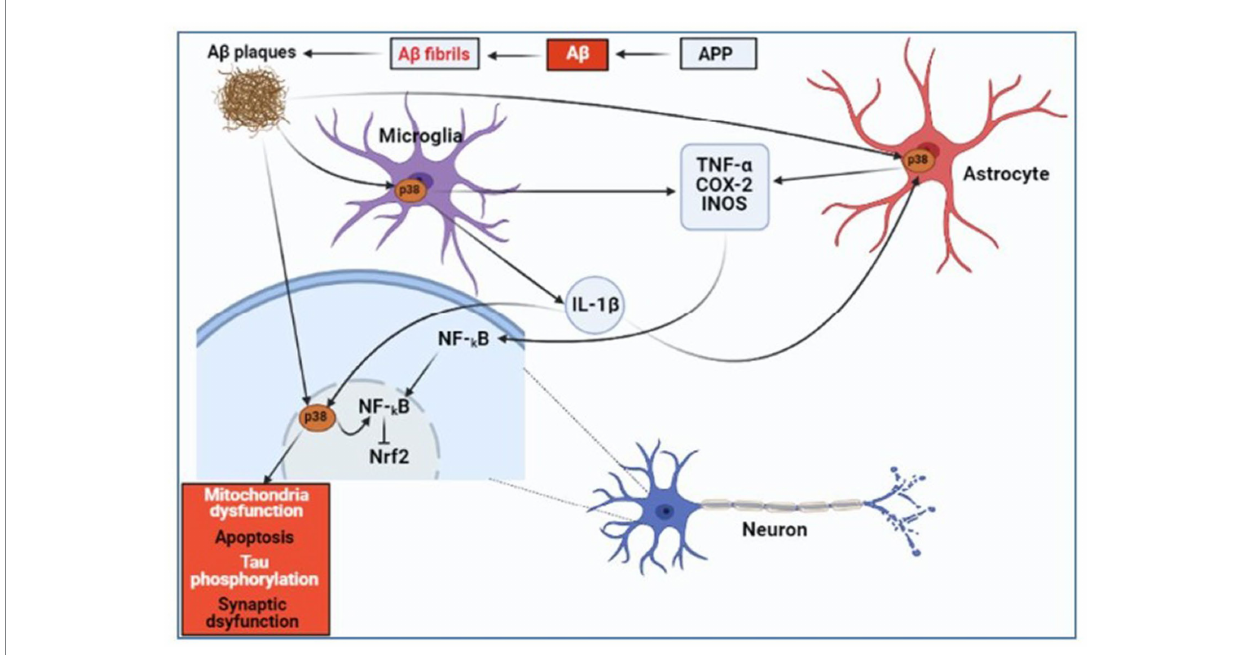
FIGURE 6 Diagrammatic representation of how A β causes neuroinflammation in AD. A β , amyloid-beta; NF- κ B, Nuclear factor- κ B; p38 MAPK, p38 Mitogen- activated protein kinases; Nrf2, Nuclear factor E2-related factor 2; IL-1 β , Interleukin-1 β ; TNF- α , Tumor necrosis factor- α ; COX-2, Cyclooxygenase-2; and iNOS, Inducible nitric oxide synthase (Schnöder et al., 2016; Lee and Kim, 2017). Created with BioRender.com.